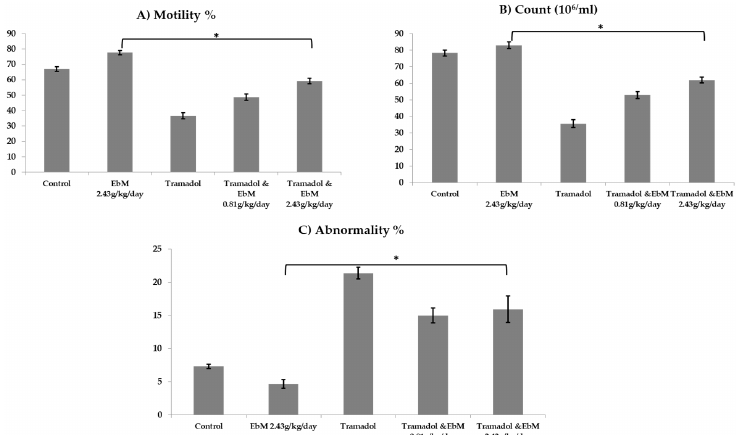
Figure 3. The efficacy of oral uptake of E. brevicornum extract and/or tramadol on semen parameters. Figure 3. The e ffi cacy of oral uptake of E. brevicornum extract and / or tramadol on semen Tramadol-administered rats resulted in a remarkable decrease in sperm motility ( A ) and count ( B )